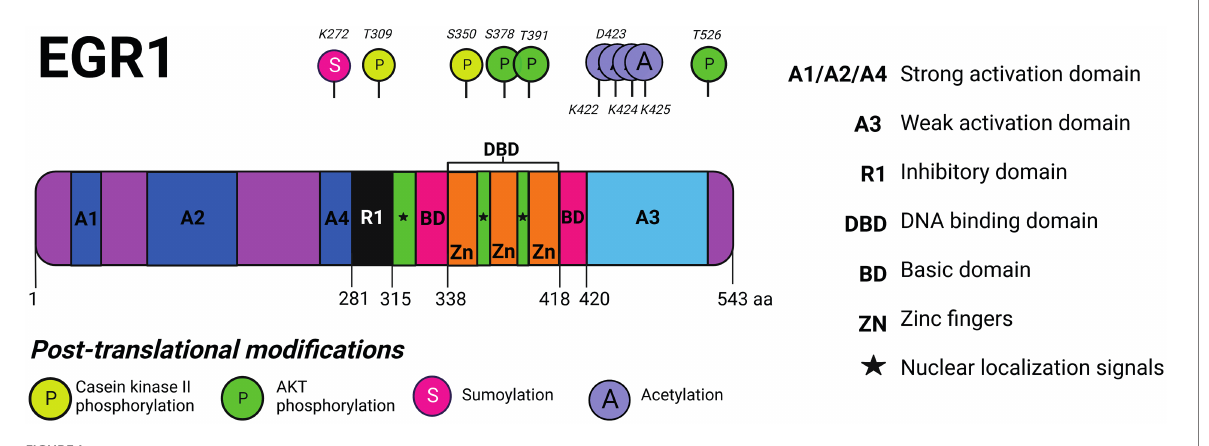
FIGURE 1 EGR1 protein domains and post-translational modifications. The multiple protein domains of EGR1 are depicted including its strong activation domain, weak activation domain, inhibitory domain, DNA binding domain, and basic domain as well as its zinc finger motifs and nuclear localization signals (NLS). EGR1 is phosphorylated by AKT on S378, T391, and T526 and by casein kinase II (CKII) on T309 and S350. EGR1 is sumoylated on K272 and acetylated on K422, D423, K424, and K425. Created with